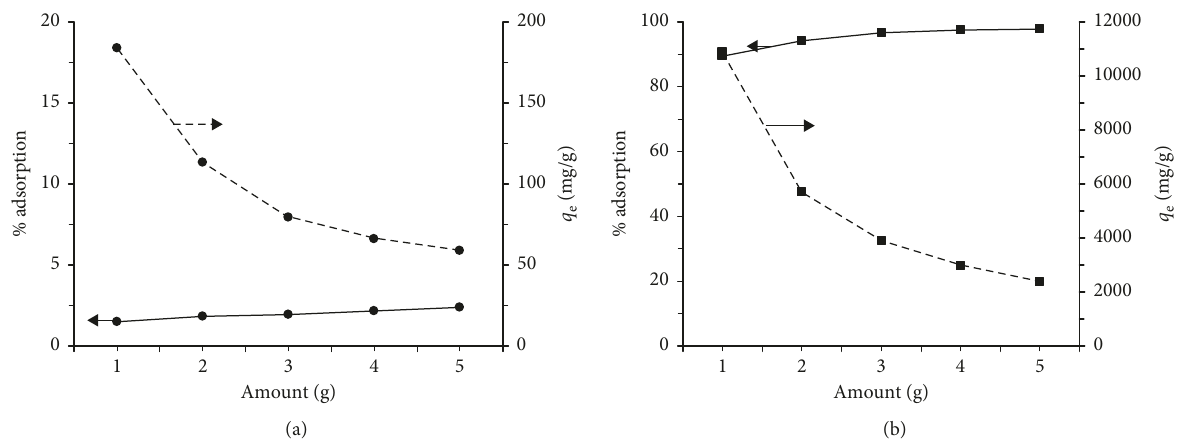
Figure 5: Graphical relationship of percent adsorption, adsorbent dosage, and adsorption capacity at equilibrium under laboratory-scale (a) bagasse and (b) modified bagasse.